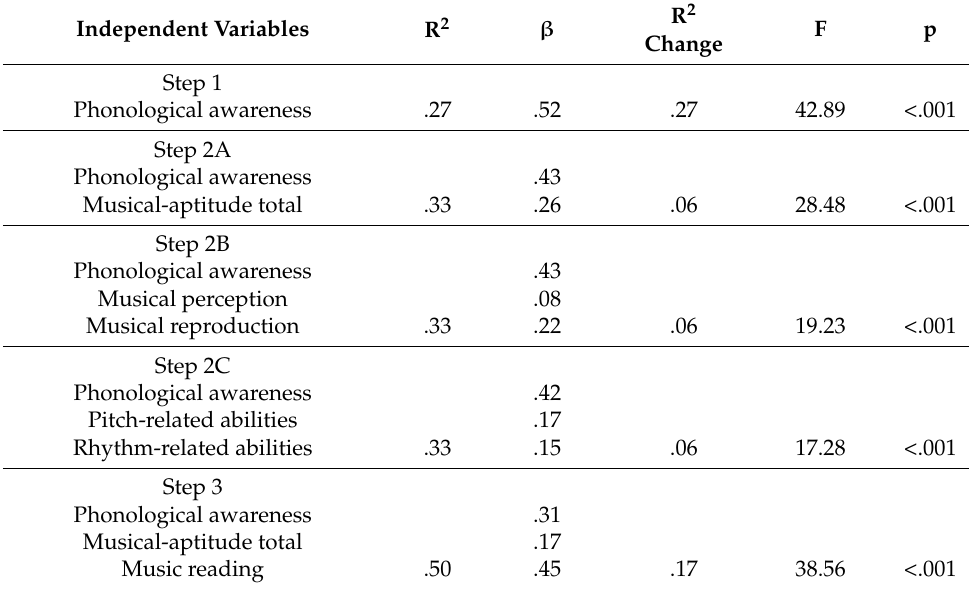
Table 3. Hierarchical regression analyses on word